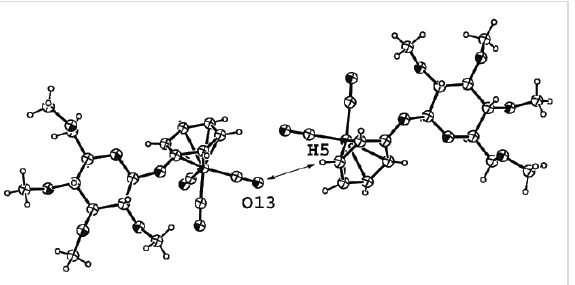
Figure 5: ORTEP-plot of the asymmetric unit showing two molecules of compound 2d and 30% probability ellipsoids; the arrows show the nonclassical H-bonds between O13 and H5.